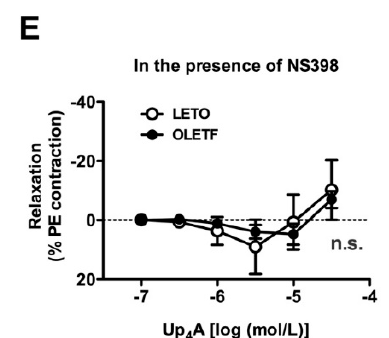
Figure 3. Effects of nitric oxide synthase (NOS) and cyclooxygenase (COX) inhibitors on the cumulative applications of uridine adenosine tetraphosphate (Up 4 A) in endothelium-intact aortas precontracted with phenylephrine (PE) from LETO and OLETF rats. Concentration-response curves for Up 4 A in endothelium-intact aortas precontracted with PE (10 − 6 mol/L) in the presence of a non-selective NOS inhibitor (L-NNA, 10 − 4 mol/L) ( A ), COX inhibitor (indomethacin, 10 − 5 mol/L) ( B ), L-NNA (10 − 4 mol/L) plus indomethacin (10 − 5 mol/L) ( C ), a selective COX1 inhibitor (VAS, 10 − 4 mol/L) ( D ), or a selective COX2 inhibitor (NS398, 10 − 6 mol/L) ( E ). The points show the means ± standard errors as percentages of the relaxation of the contraction induced by PE (10 − 6 mol/L ( B , D , E ) or 10 − 7 mol/L ( A , C )). n = 6 or 8. * p < 0.05 corresponding LETO group. LETO, Long-Evans Tokushima Otsuka